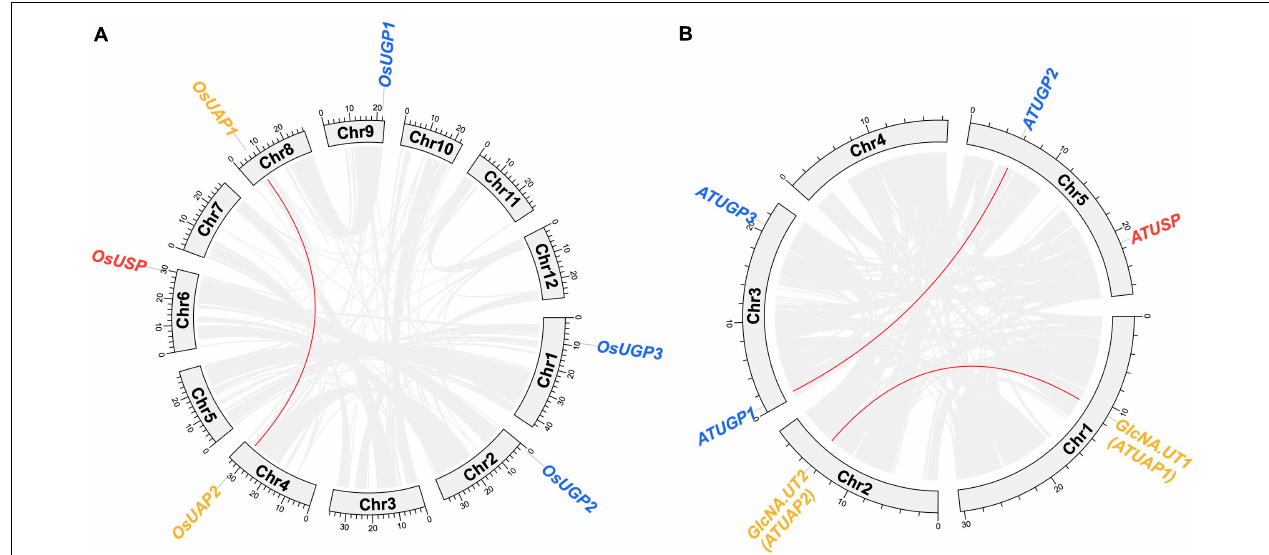
FIGURE 3 | Chromosome distributions of UDP glucose pyrophosphorylases (UDPGPs). The chromosomal distributions of UDPGP genes in Oryza sativa (A) and Arabidopsis thaliana (B) are shown in the outer circle, where the numbers represent the chromosome length 10 Mb. The synteny and collinearity genes detected by MCScanX are connected by red arcs in the inner